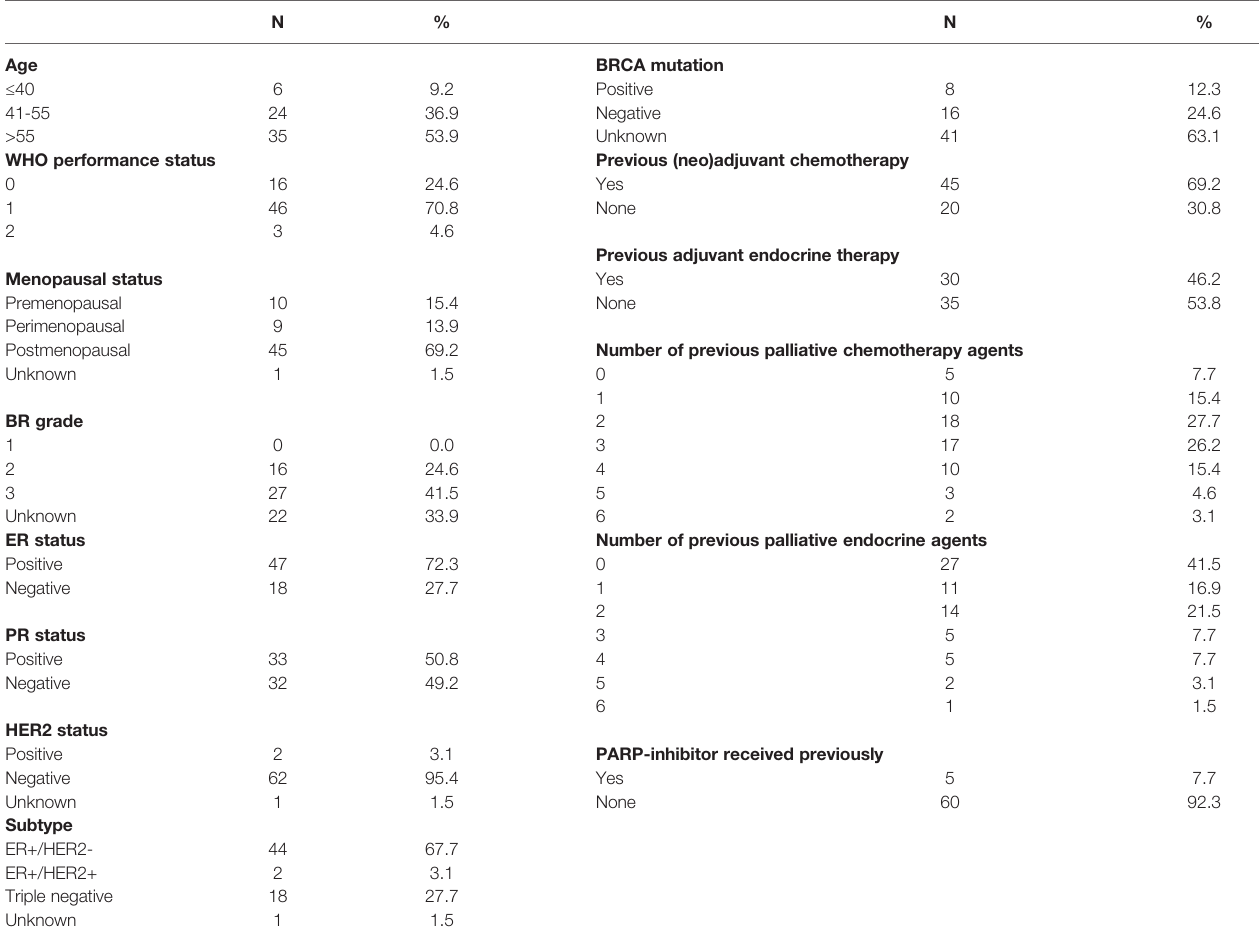
TABLE 1 | Patient characteristics ( n